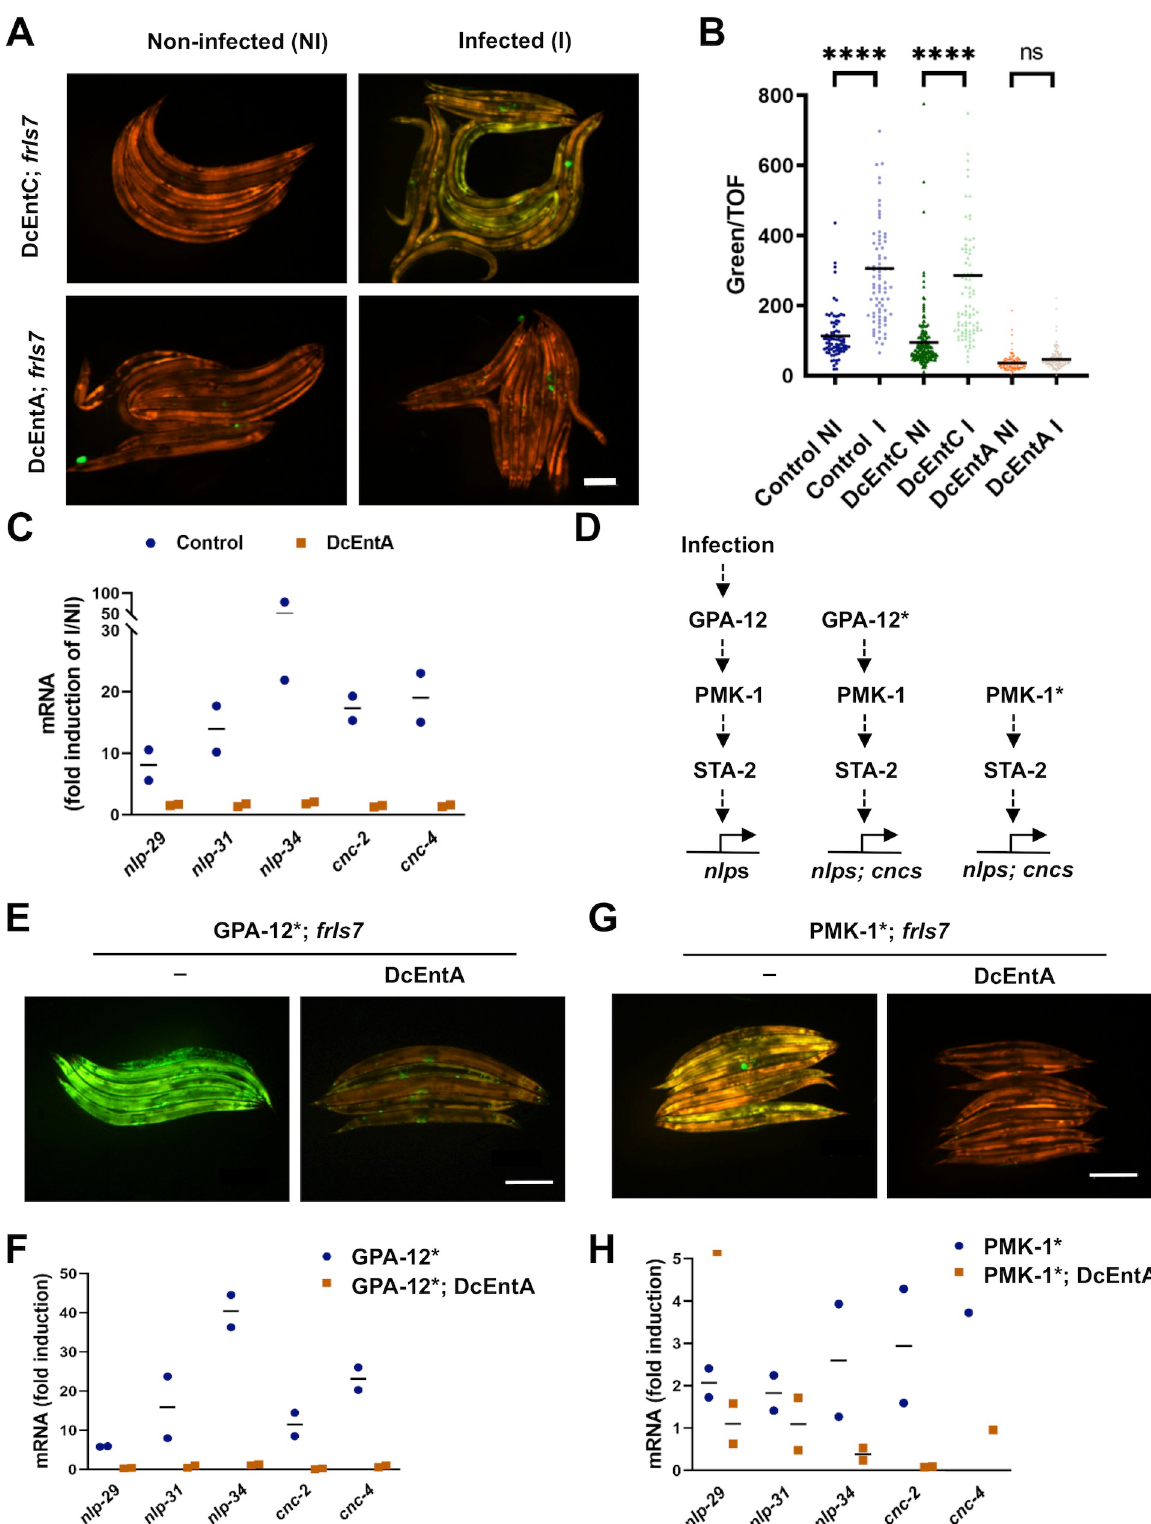
Fig 3. DcEntA blocks AMP gene expression after infection. ( A ) Representative images of DcEntC; frIs7 (IG1883; upper panels) and DcEntA; frIs7 (IG1942; lower panels) worms either not infected (left), or 20 h after infection with D . coniospora (right) as young adults. frIs7 includes nlp-